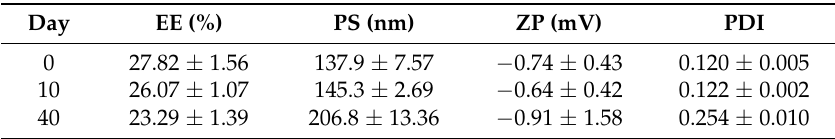
Table 5. Characterization of TGP-E (mean ± SD, n =